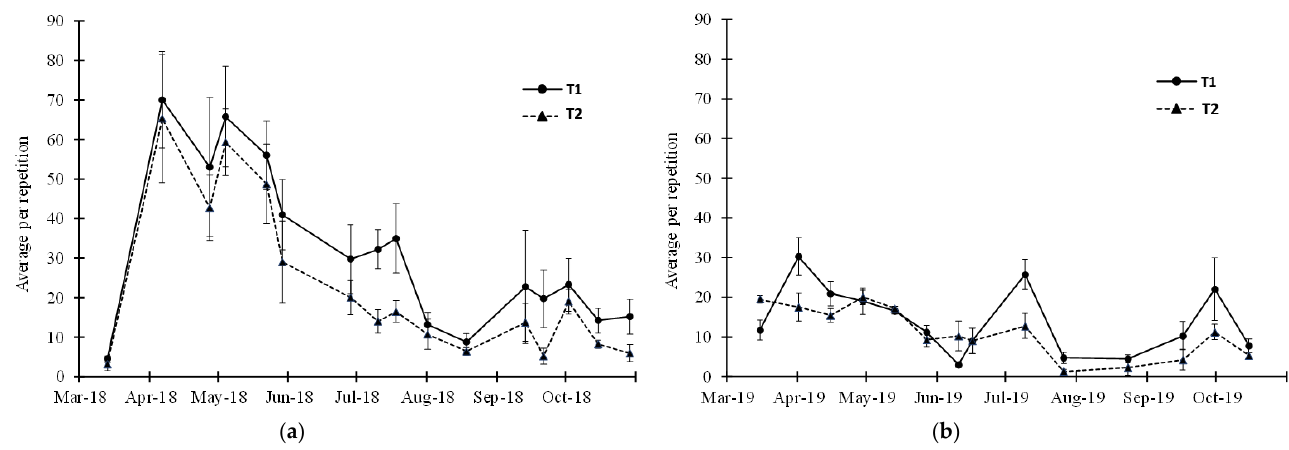
Figure 2. Evolution along time for the average population of the total arthropod found using vacuum sampling in the two irrigation treatments: ( a ) in 2018 and ( b ) in 2019. The solid line represents treatment T1 (control), and the dotted line represents treatment T2 (Confederation RDI). The vertical bars represent the standard error of the mean.